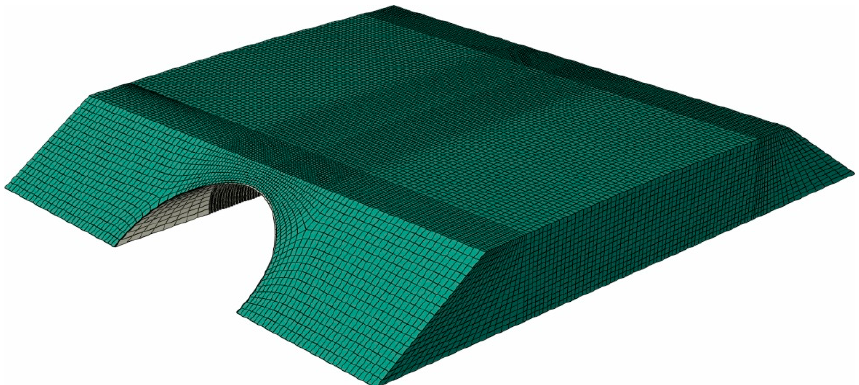
Figure 20. Finite element method (FEM) computational domain of the bridge.